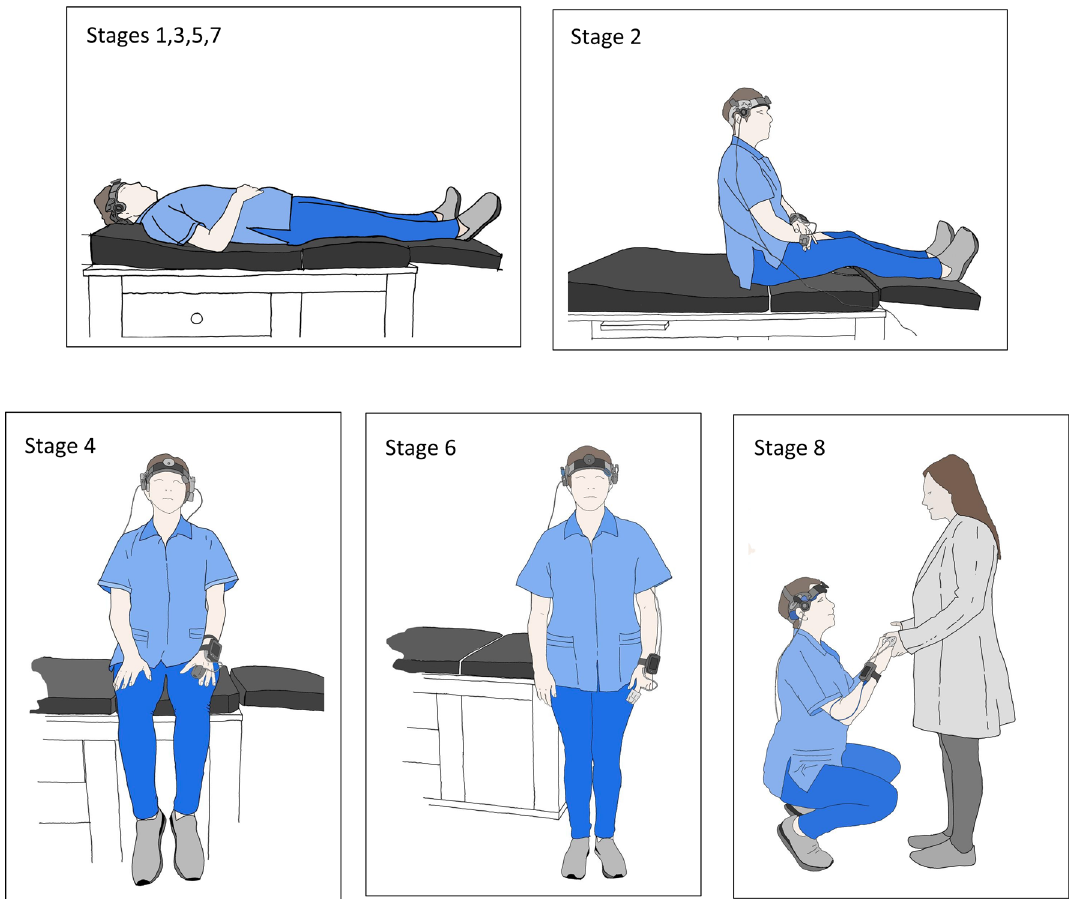
Figure 1. MMDD procedure: Resting stage: Stages 1, 3, 5, 7 (laying down). Testing stages Stage 2; sitting with the legs in the horizontal position, Stage 4; sitting with the feet hanging. Stage 6; Standing up. Stage 8; physical activity (15 genuflections or 15 ascents of a